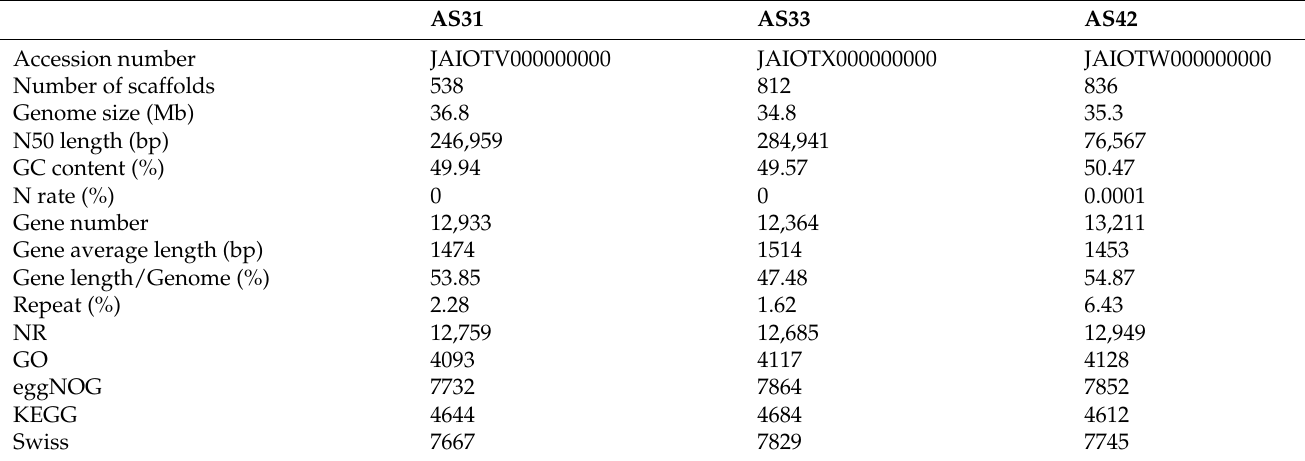
Table 1. Genome features of strains AS31, AS33, and